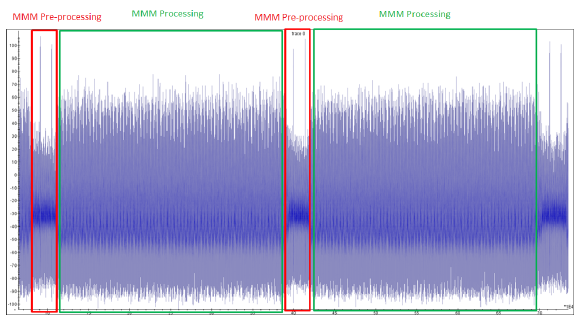
Figure 4: EM emanation during a single loop of Algorithm